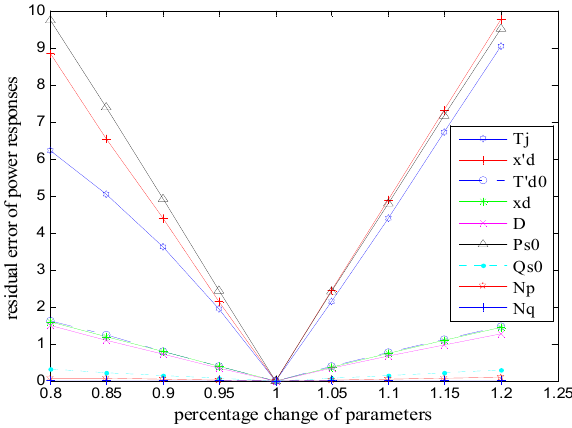
Figure 5. Residual error of power responses with different parameters.